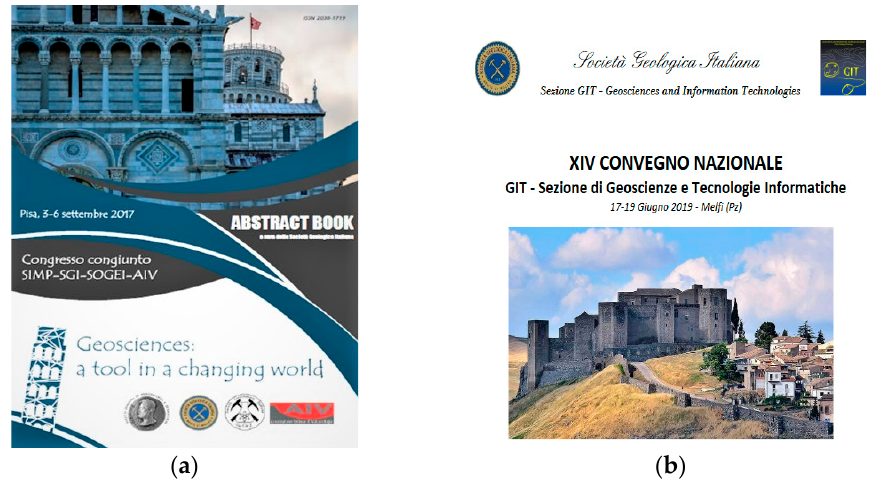
Figure 12. ( a ) The cover of the abstract book of the International Congress entitled Geosciences: a tool in a changing world , held in Pisa in 2017; ( b ) the cover of the abstract book of the Fourteenth National Meeting of GIT (Geosciences and Information Technologies), a section of the Italian Geological Society, held in Melfi (PZ) in 2019.